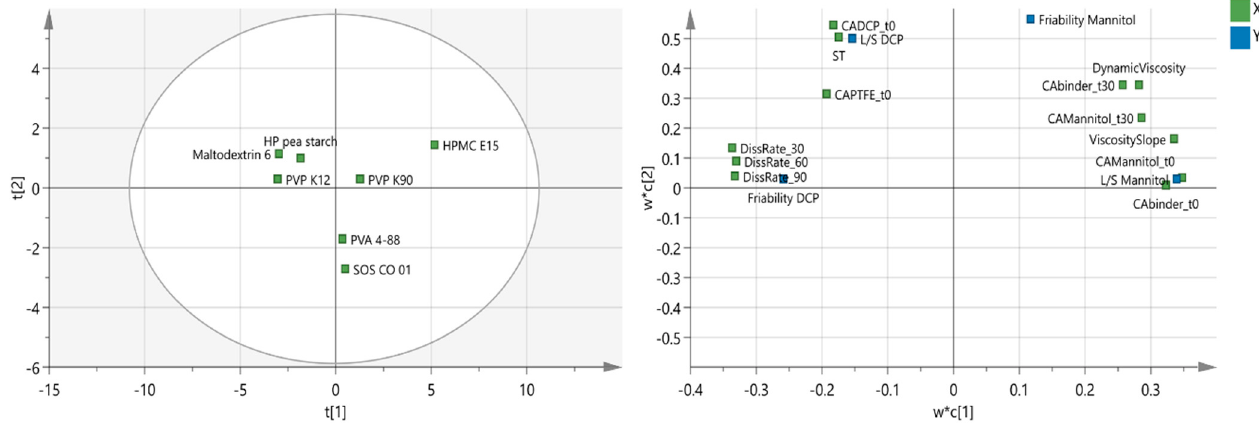
Figure 8. PLS model with score scatter plot (left), and loading scatter plot (right) for the first and second PC. “L/S DCP” and “L/S mannitol” refer to the L/S-ratio needed to meet the friability limit of 30%. “Friability DCP” and “friability mannitol” indicate the lowest friability that could be achieved with a binder regardless of the amount of granulation liquid [16].